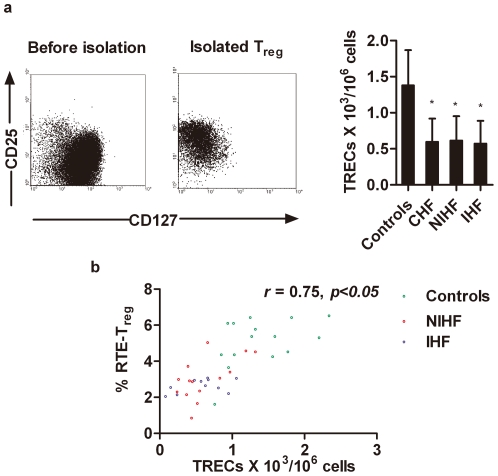
Analysis of intracellular T-cell receptor excision circle (TREC) levels in purified Treg cells from CHF patients and non-CHF controls.a. CD4+CD25+CD127low Treg cells from CHF patients (n = 25, 14 NIHF and 11 IHF) and non-CHF controls (n = 15) were isolated by magnetic selection (left), and the TREC levels were determined by RT-PCR (right; *p<0.01) and compared to non-CHF controls. b. RTE-Treg frequencies were plotted against TREC levels in purified Treg cells from CHF patients and non-CHF controls (r = 0.75, p<0.001).